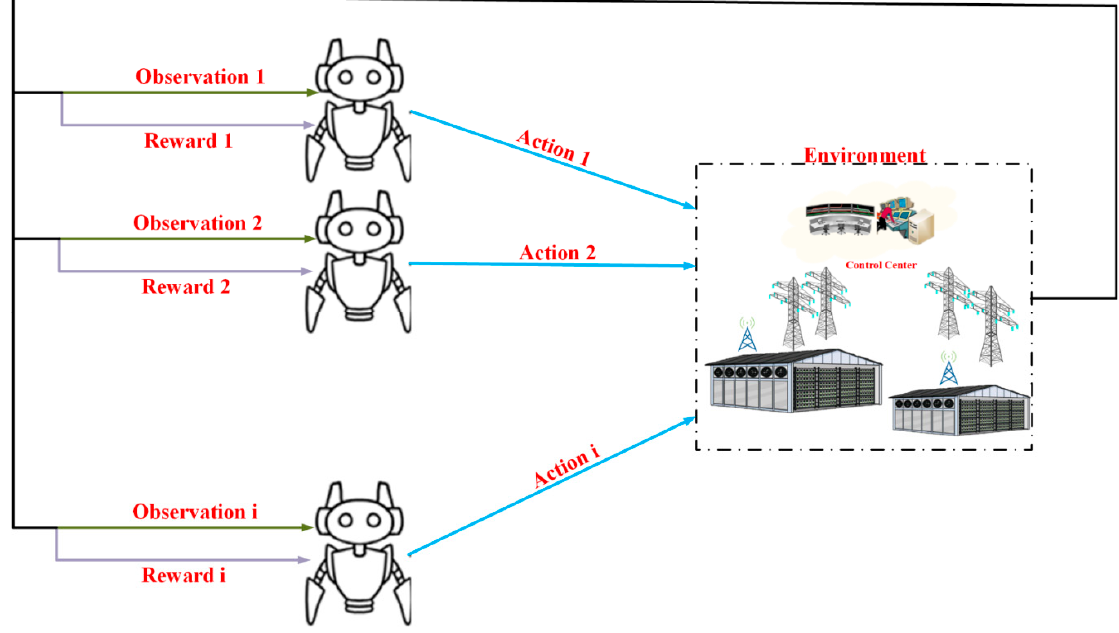
Figure 2. The reinforcement learning structure.